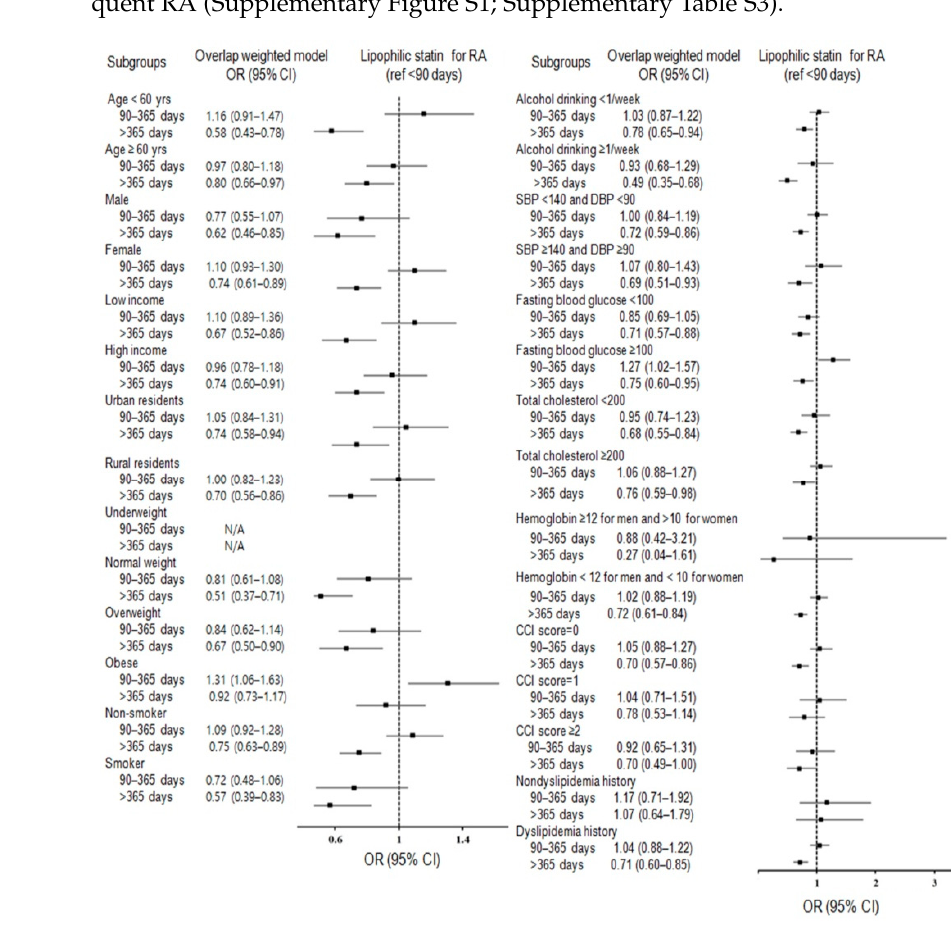
Figure 3. Forest plots depicting the association between use duration of lipophilic statin and a subsequent risk of incident rheumatoid arthritis (RA) in each